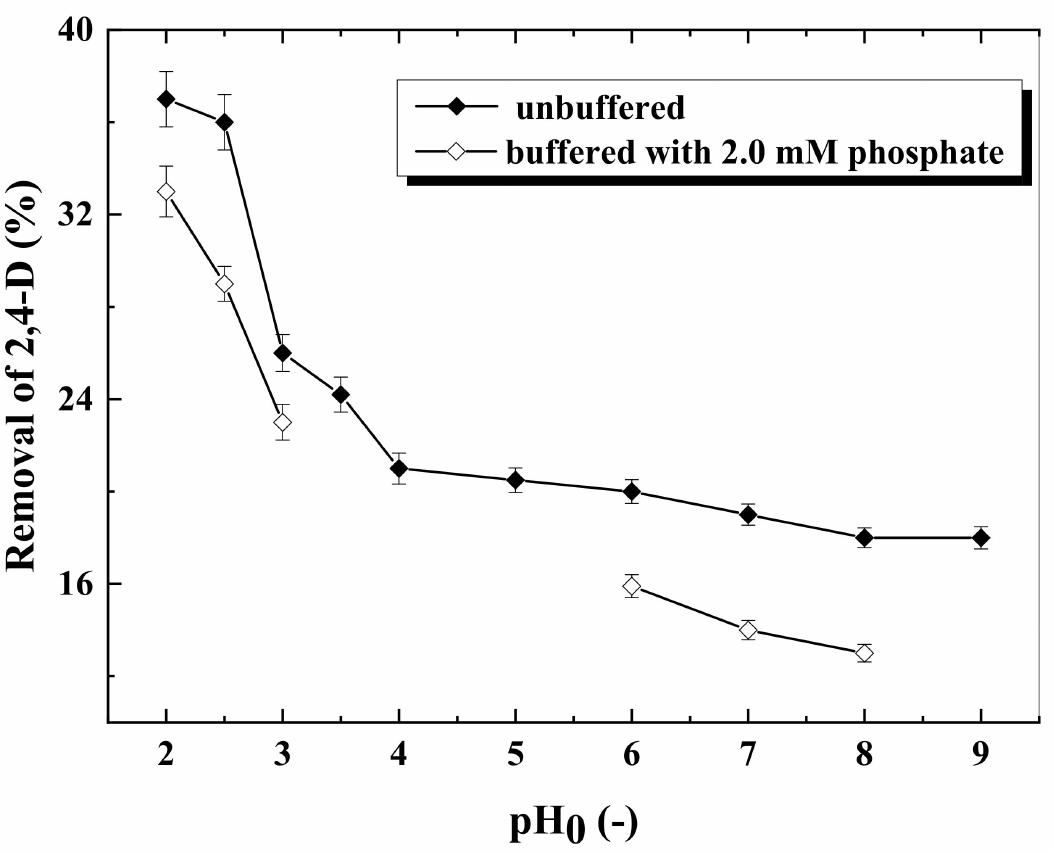
Figure 4. 2,4-D removal under different initial pH values in buffered and unbuffered solutions (input power, 200 W; [2,4-D] 0 , 1.0 mM; discharge time, 10